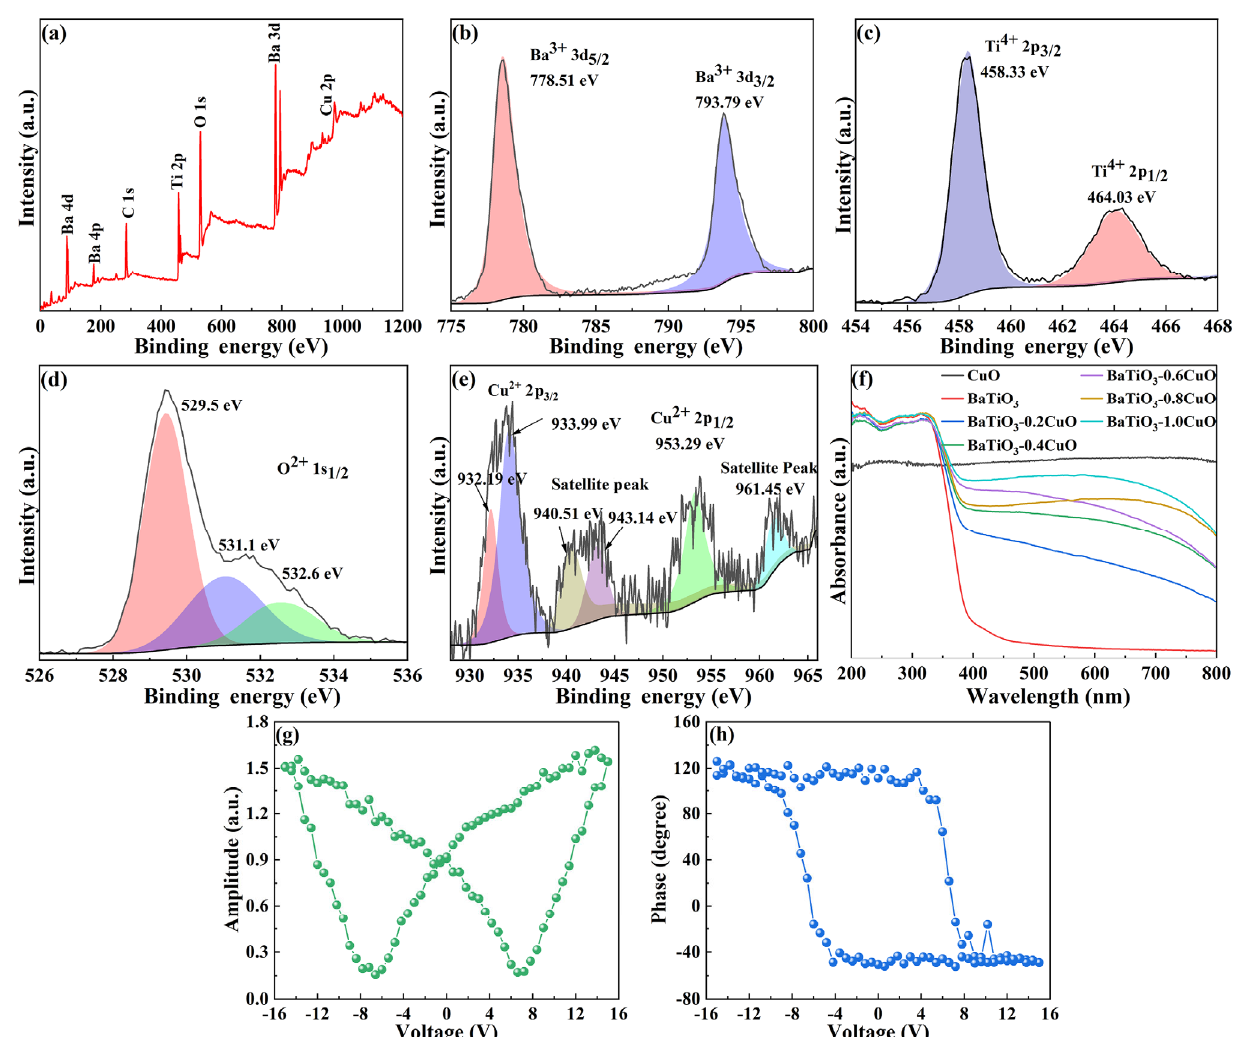
Fig. 3 XPS spectra of BaTiO 3 –0.6CuO: (a) survey, (b) Ba 3d, (c) Ti 2p, (d) O 1s, and (e) Cu 2p; (f) UV–Vis diffuse reflectance spectra of BaTiO 3 /CuO heterostructures; and PFM strain–voltage hysteresis loop of (g) amplitude and (h) phase for BaTiO 3 –